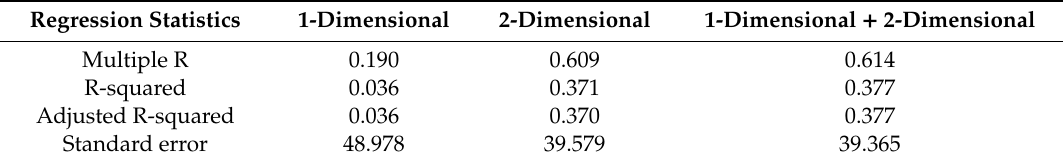
Table 4. Regression statistics of time data representation.